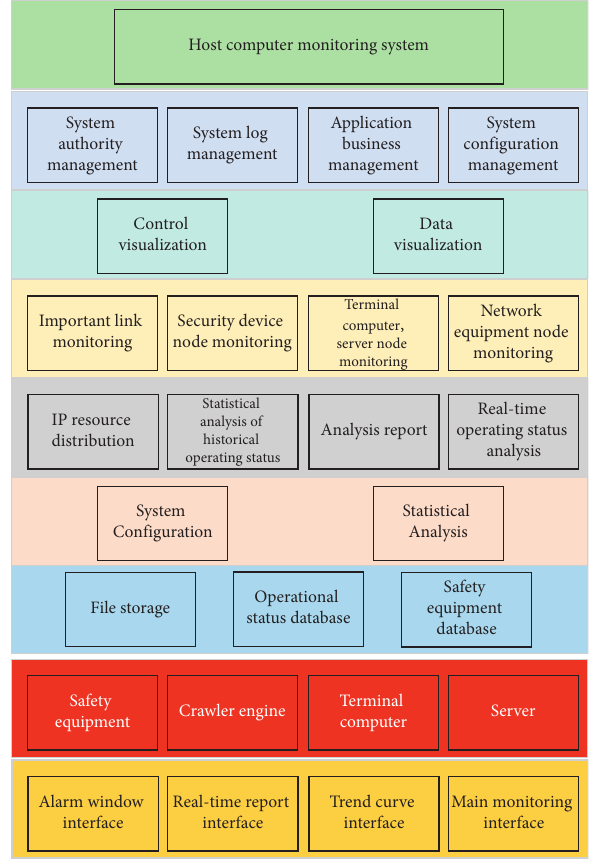
Figure 3: The structure of the host computer monitoring